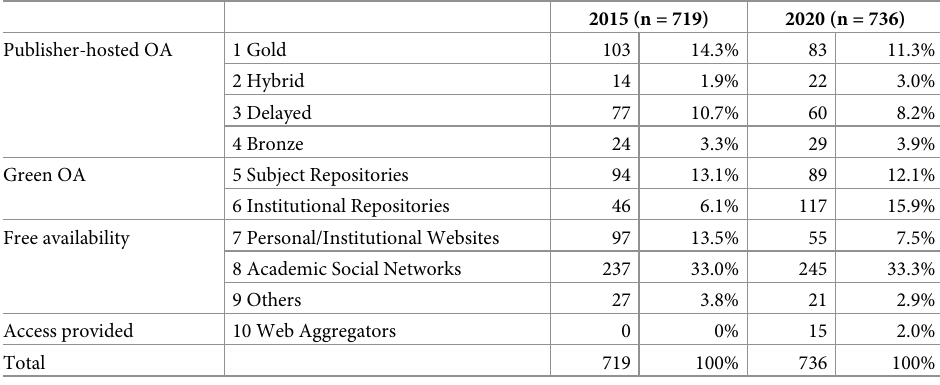
Table 5. Number of open access (OA) articles made available through a single mode.